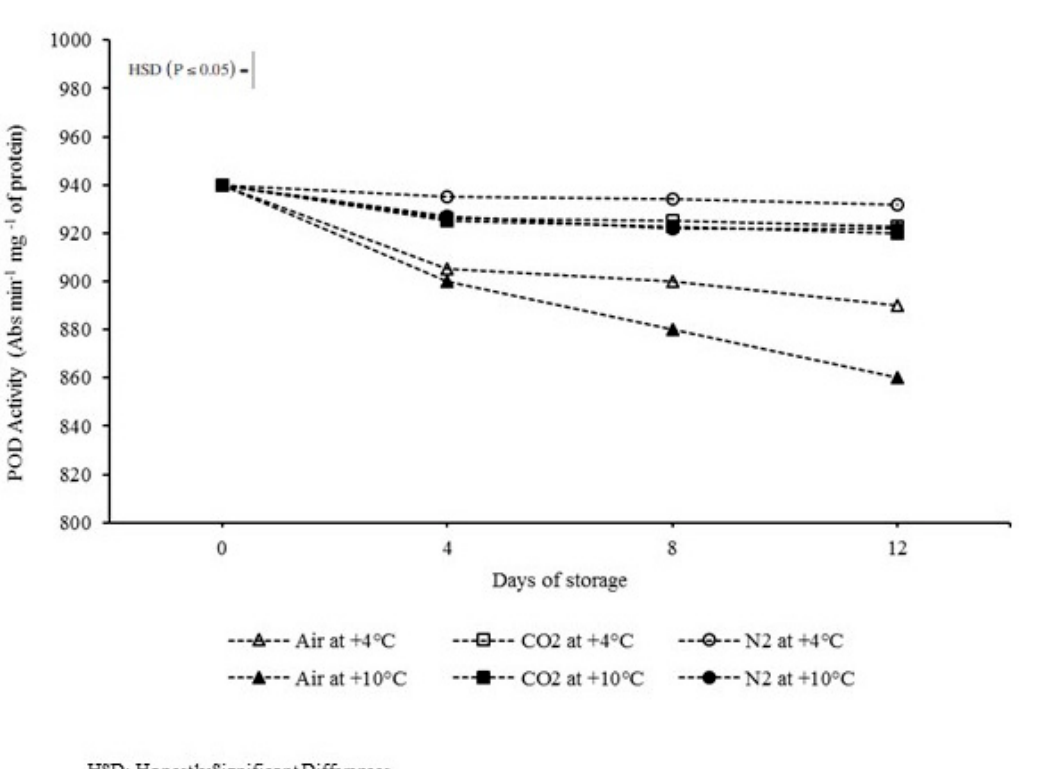
Figure 6. Peroxidase activity (POD) over 12 days of storage at +4 °C and +10 °C in air, 100 ± 1 kPa of CO 2 , and 100 ± 1 kPa of N 2 , respectively.